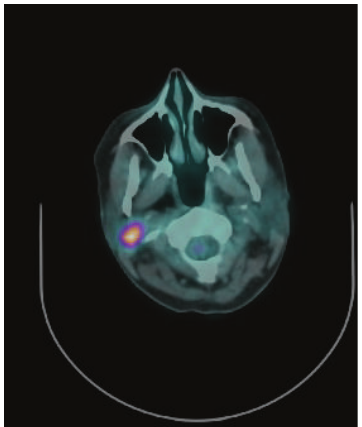
Figure 1: Pet CT showing accumulation of 18-FDG in the right parotid gland.